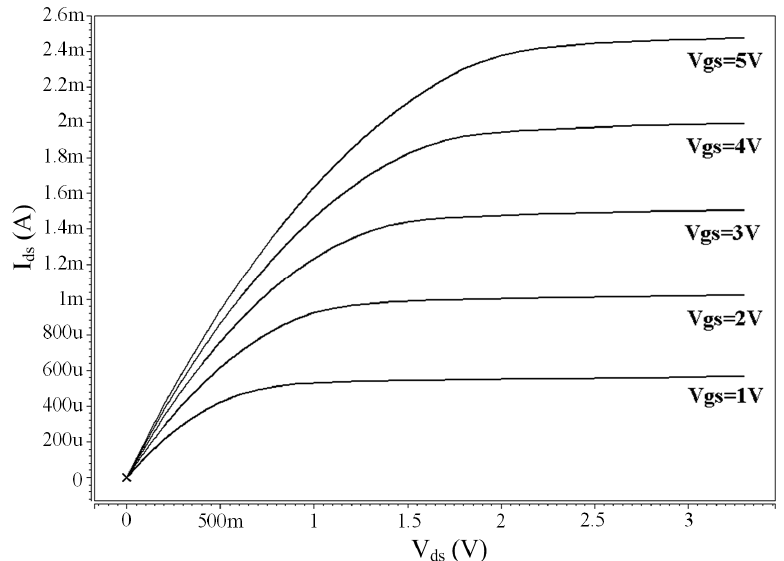
/ V characteristics for the FET pressure ds ds